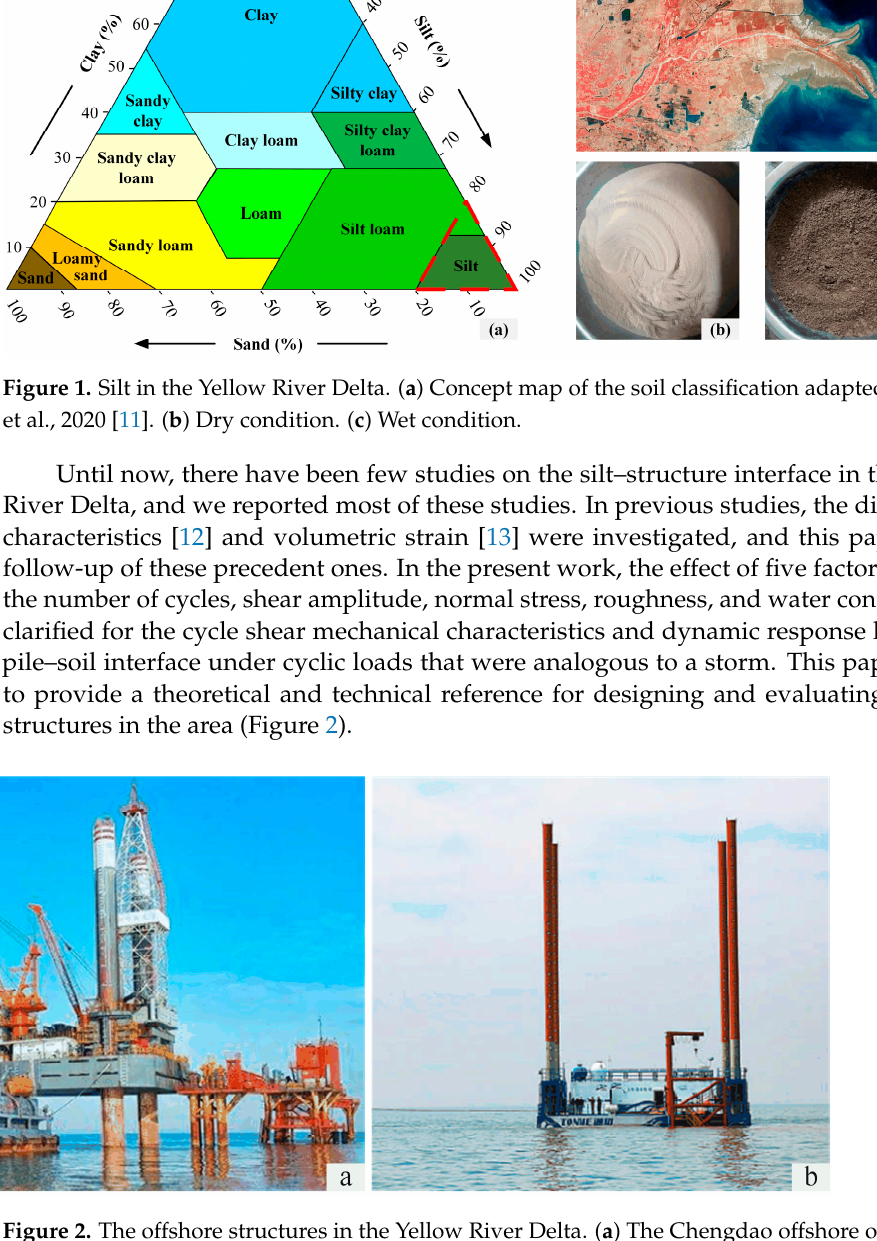
Figure 2. The offshore structures in the Yellow River Delta. ( a ) The Chengdao offshore oil platform. ( b ) The Hekou jack-up marine ranching platform.